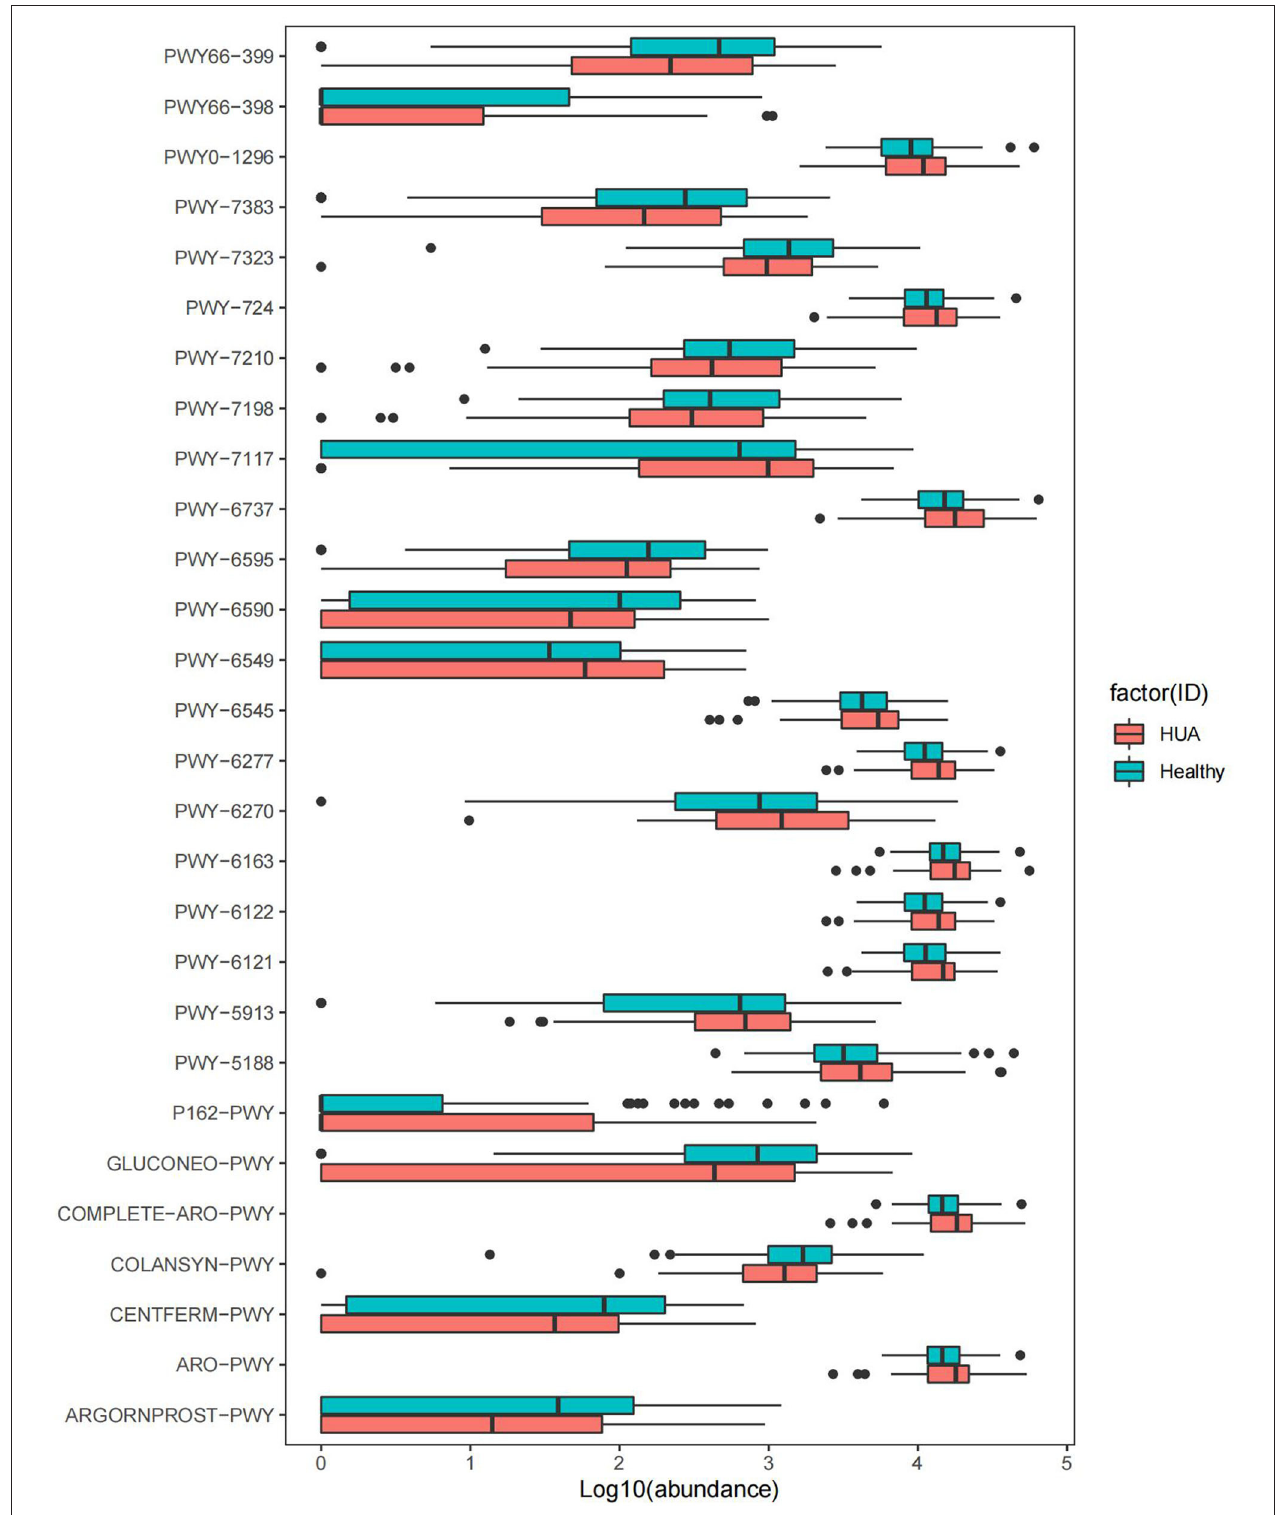
FIGURE 3 | MetaCyc pathways with significant difference abundance between HUA group and healthy controls (Wilcoxon rank sum test, P < 0.05).